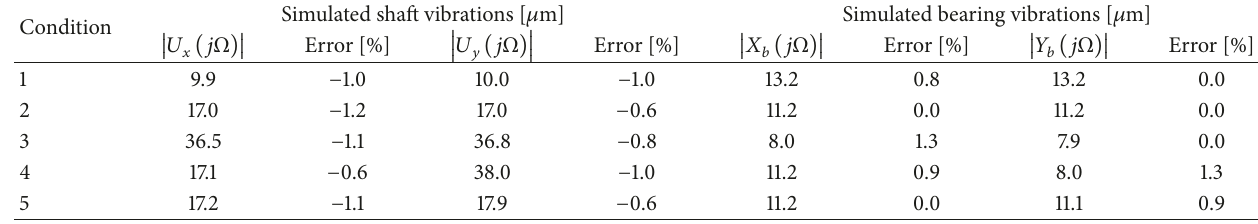
Table 7: Simulated shaft and bearing vibrations at the lower journal bearing, using the estimated bearing effective stiffnesses, including the errors in comparison to the vibrations shown in Table 5.